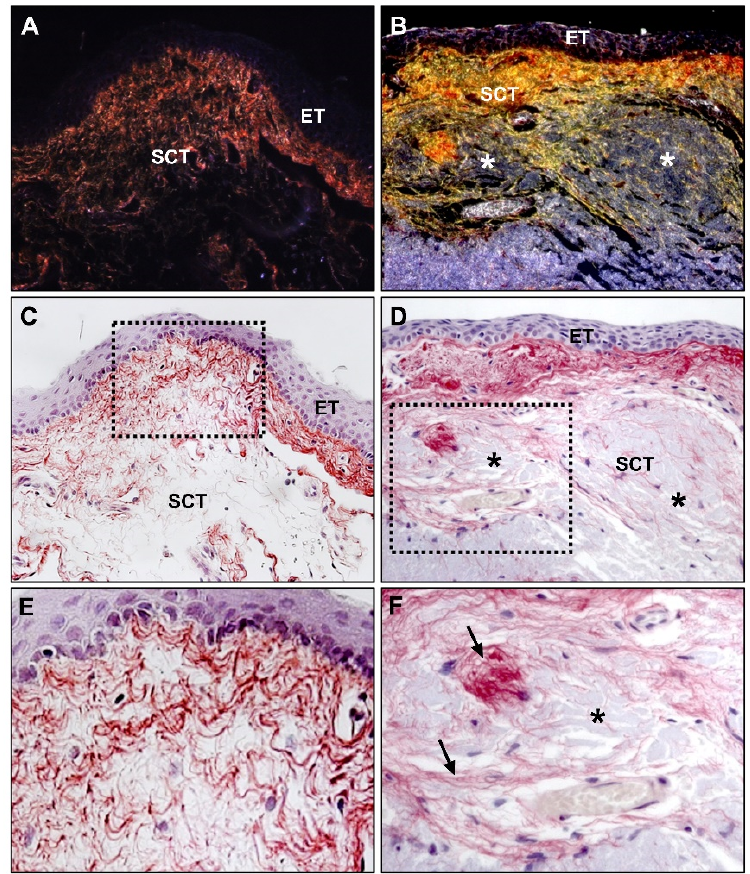
Figure 4. Photomicrographs of Sirius red staining observed under polarized light of ( A ) conjunctival and ( B ) pterygium tissue, showing expression of collagen I (mature) in red and collagen III (immature) in yellow, in the subepithelial connective tissue of both specimens ( × 200); ( C ) conjunctival and ( D ) pterygium tissue images of the same samples stained with Sirius red observed under normal light, where collagen expression appears in red ( × 200); ( E , F ) magnification of the squared area from the ( C , D ) image showing collagen fibers ( → ) ( × 400). (ET, epithelial tissue; SCT, subepithelial connective tissue; *, areas of amorphous and fibrillar material accumulation; → , collagen